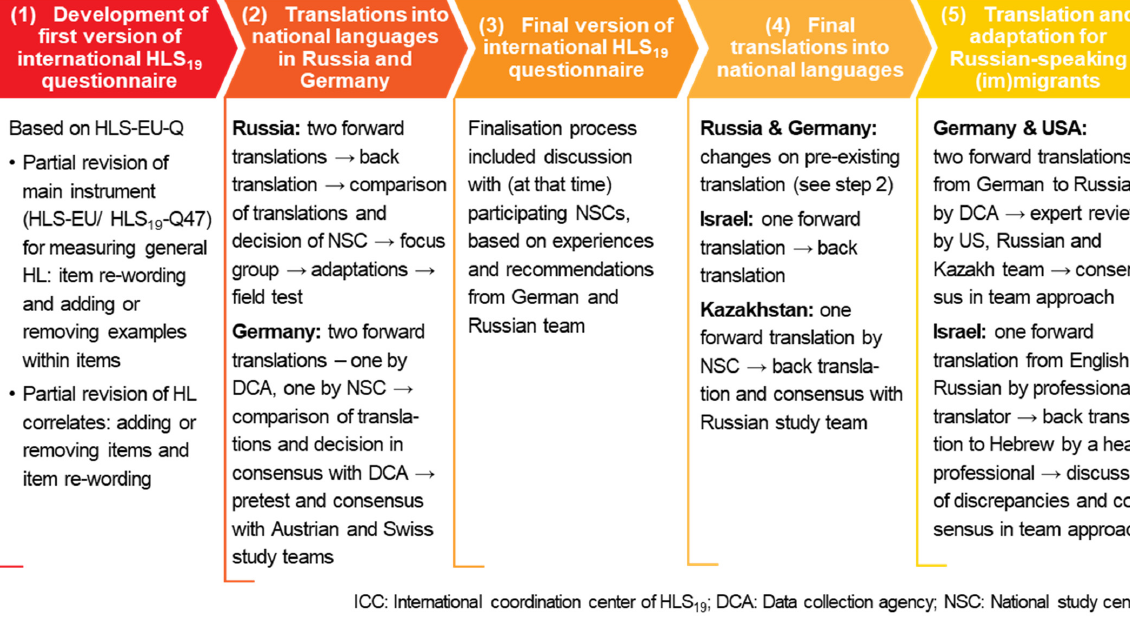
Figure 1. Steps of the HLS 19 questionnaire adaptation.